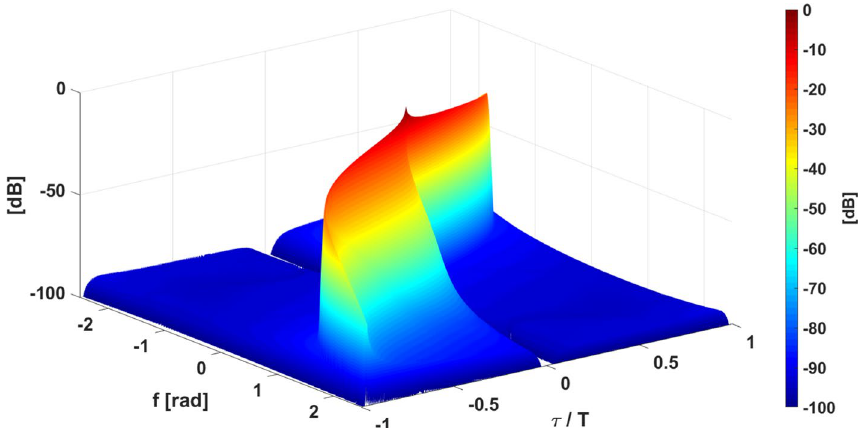
Fig. 4 Ambiguity function of a HNLFM chirp in decibel (dB) below the peak. BT the duration T , normalized Doppler frequency in